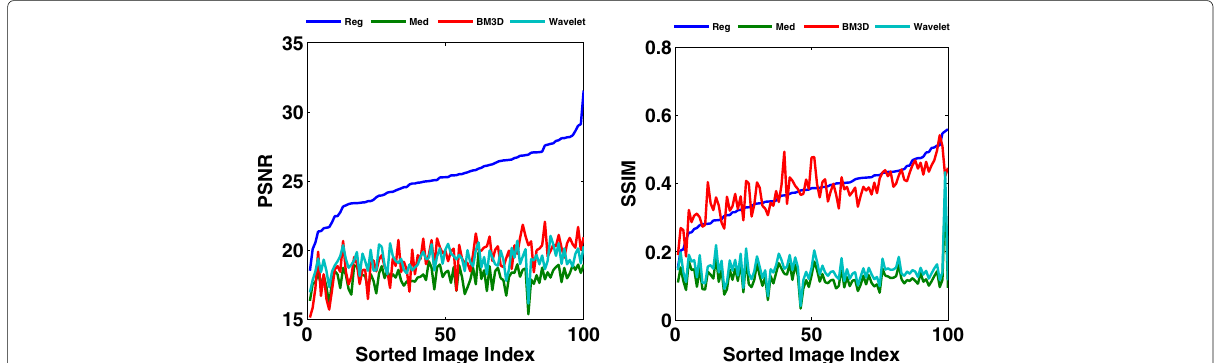
Fig. 16 One-hundred sample images denoised using our regression filter, median, BM3D, and wavelet filters with Gaussian ( σ = 175) and Poisson